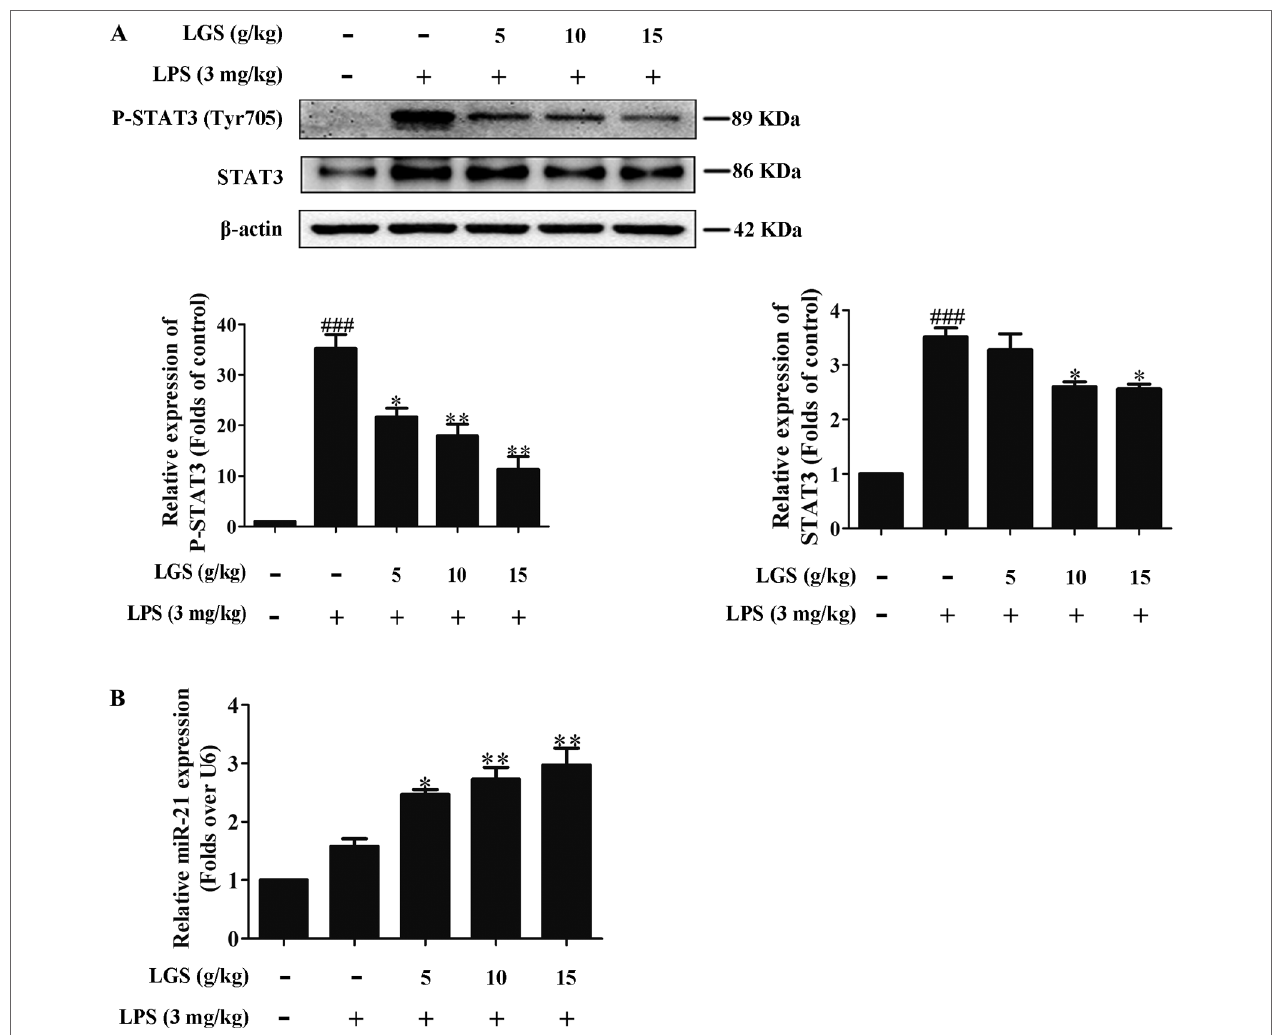
FIGURe 7 | LGS inhibits the STAT3 signaling pathway by up-regulating miR-21 in ALI mice. Forty-eight mice were randomly divided into six groups each experiment. (A co-worker blinded to the experimental protocol randomized animals, n = 8/group.) After sacrifice, the lung tissues in ALI mice were harvested and the total proteins and RNA were extracted, respectively. (A) LGS inhibits the STAT3 signaling pathway in ALI mice. The protein expressions of STAT3 and P-STAT3 (Tyr705) were detected by Western blotting. (B) LGS enhances the expression of miR-21 in ALI mice. The expression of miR-21 in lung tissues was measured by qPCR. Data are represented as the mean ± SEM of three independent experiments. ### P 0.001 versus control, * P < 0.05, ** P < 0.01 and versus LPS treatment by one-way ANOVA with Tukey’s test.